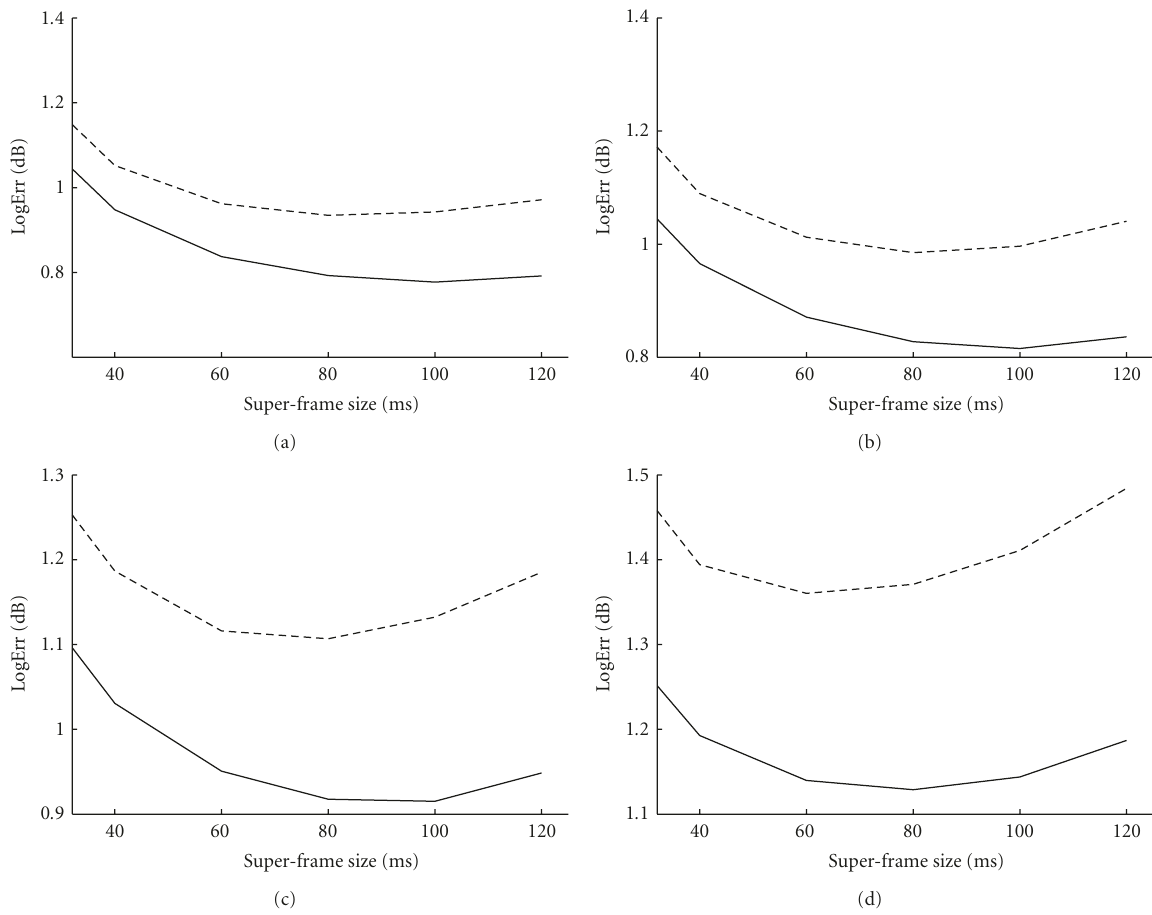
Figure 3: Noise tracking performance in terms of LogErr (dB) as a function of the length of the super-frames for stationary Gaussian white noise (solid line) and nonstationary Gaussian white noise (dashed line) at an input SNR of (a) 0dB (b) 5 dB (c) 10 dB (d) 15